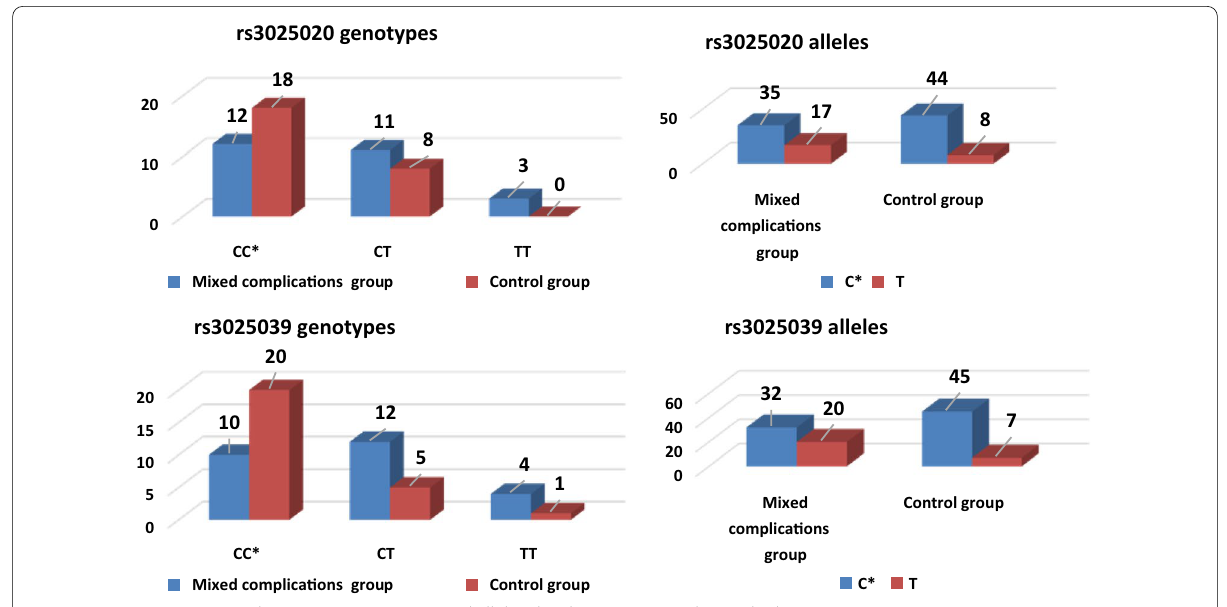
Fig. 3 VEGF-A rs3025020 and rs3025039 genotypes and alleles distribution among the studied groups